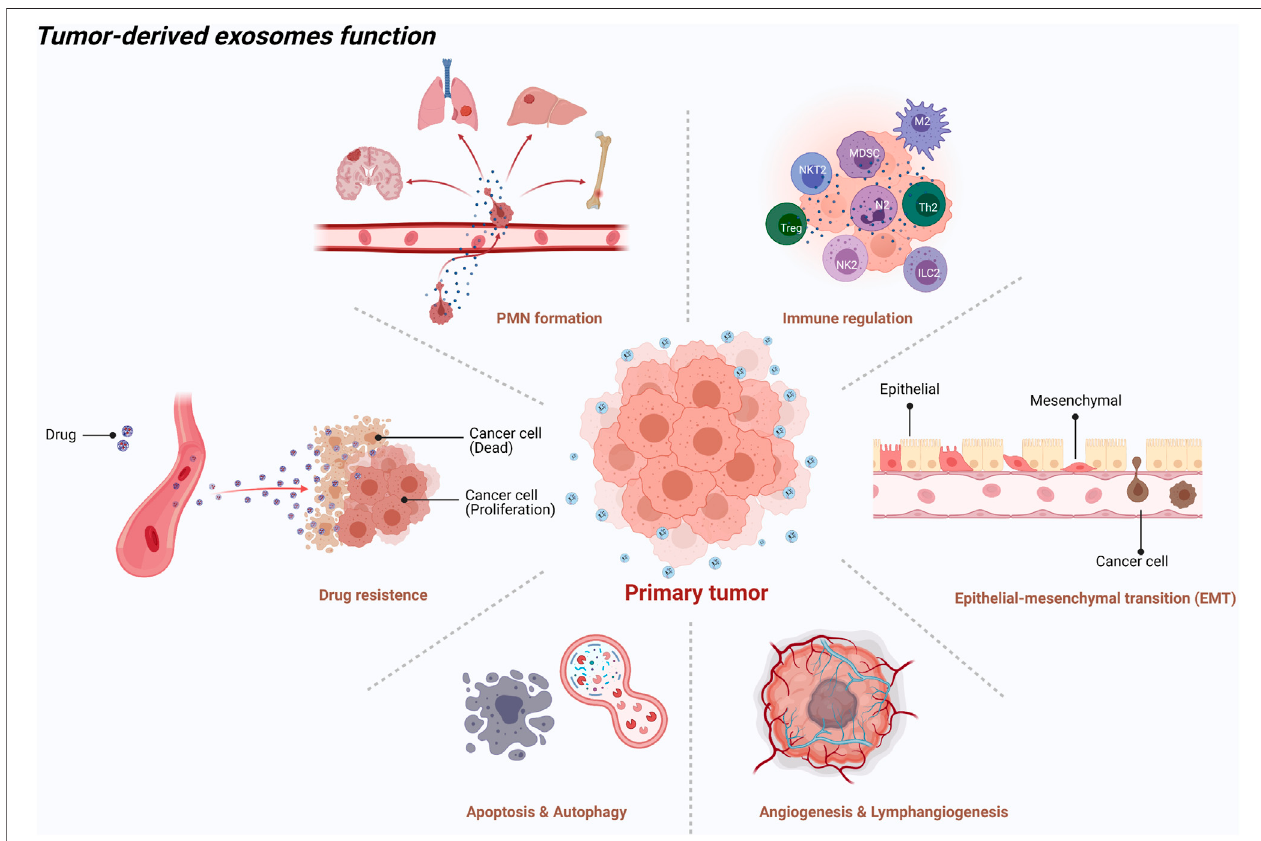
FIGURE 1 | An illustration showed the tumor-derived exosomes function [created with BioRender.com (https://biorender.com/)].